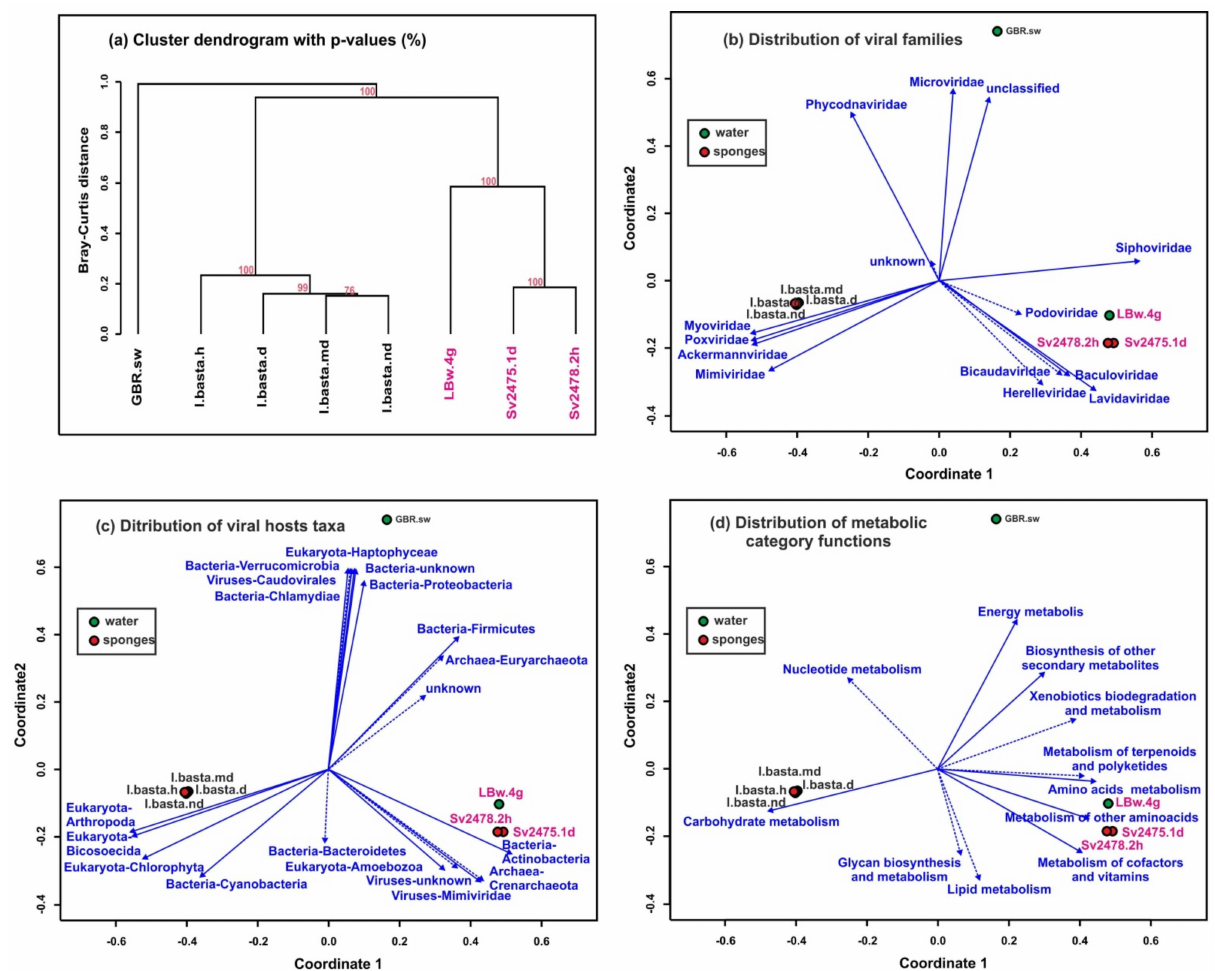
Figure 5. Clustering of samples by similarity of the representation of scaffolds identified as viral. ( a ) Dendrogram constructed by the “average” method based on the Bray–Curtis distances (the dendrogram nodes contain the bootstrap support values). ( b – d ) Non-metric multidimensional scaling (NMDS) biplots of the virome datasets showing the following: ( b ) identification of viral taxa by homology with viral genomes and proteomes from NCBI RefSeq (vectors indicate the viral families); ( c ) viral hosts prediction, carried out using the Virus–Host database; ( d ) analysis of metabolic functional categories of viral proteins (AMGs). Unreliable vectors are marked with a dotted line. The Baikal samples are highlighted in